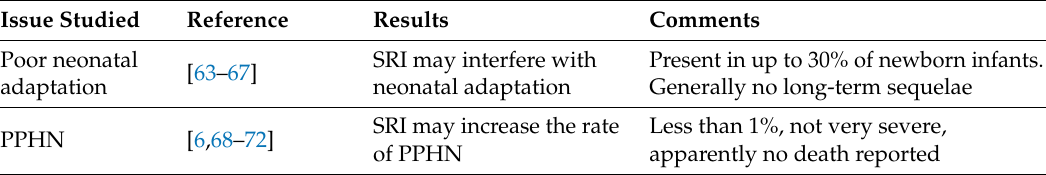
Table 2. Summary of e ff ects of serotonin reuptake inhibitors (SRI) in pregnancy: postnatal e ff